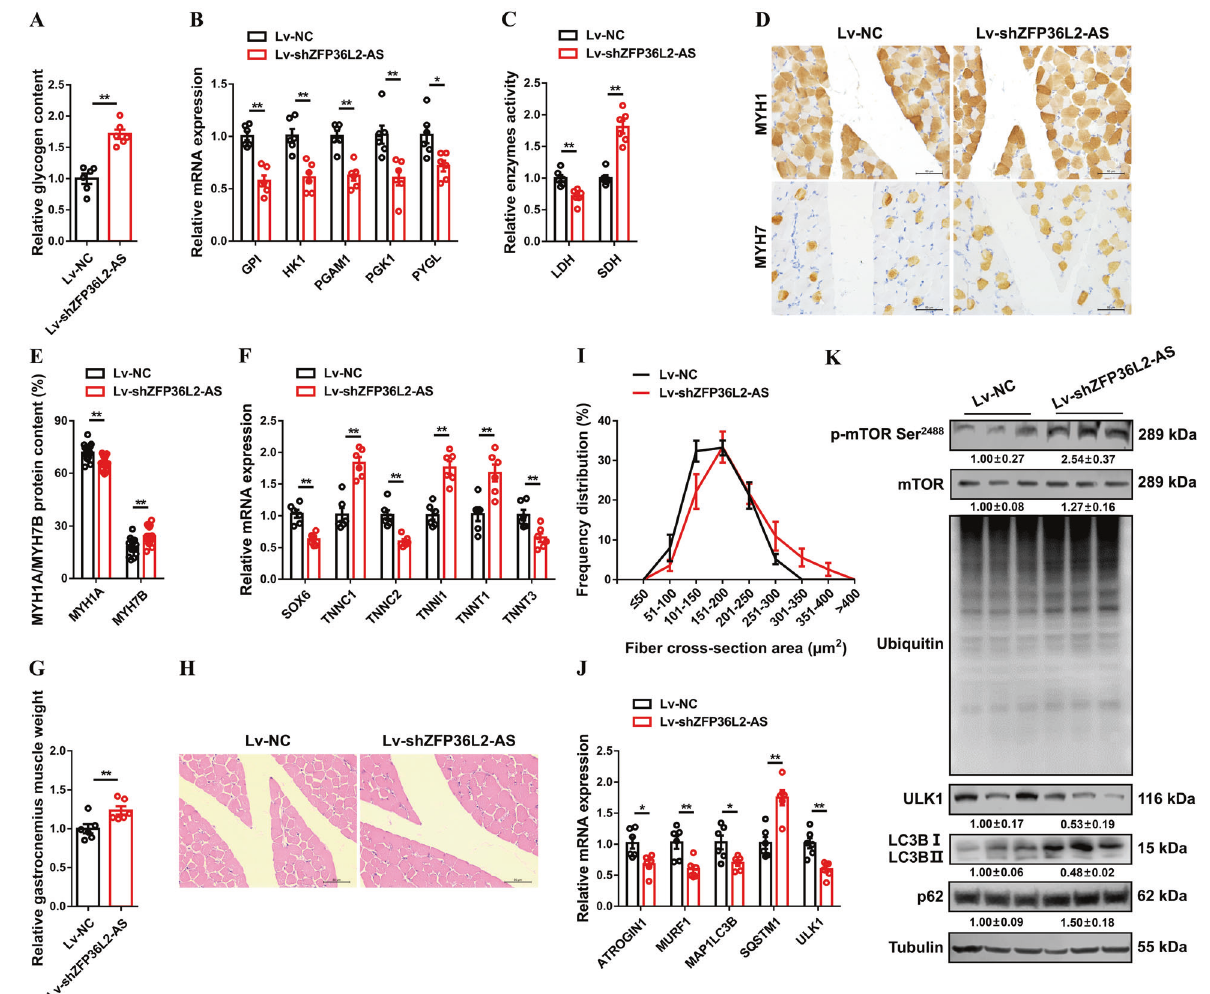
Fig. 5 lncRNA ZFP36L2-AS activates a fast-twitch gene expression pro fi le concurrent with muscle atrophy. A Relative glycogen content in gastrocnemius with ZFP36L2-AS knockdown. B Relative mRNA expression levels of glycogenolytic and glycolytic genes in gastrocnemius after infected with the indicated lentivirus. ( C ) Relative enzymes activity of lactic dehydrogenase (LDH) and succinate dehydrogenase (SDH) in gastrocnemius infected with ZFP36L2-AS knockdown. D , E Immunohistochemistry analysis of MYH1/MYH7 ( D ) and MYH1/MYH7 protein content ( E ) of gastrocnemius after ZFP36L2-AS knockdown. ( F ) Relative mRNA expression levels of several fast-/slow-twitch myo fi ber genes with ZFP36L2-AS knockdown. G Relative gastrocnemius muscle weight after infected with the indicated lentivirus. H , I H&E staining ( H ) and frequency distribution of fi ber cross-section area (CSA) ( I ) of transverse sections of gastrocnemius with ZFP36L2-AS knockdown. J Relative mRNA expression of the atrophy and autophagy-related genes in gastrocnemius after infected with the indicated lentivirus. K The protein expression levels of mTOR signaling after ZFP36L2-AS knockdown. The numbers shown below the bands were folds of band intensities relative to control. Band intensities were quanti fi ed by ImageJ and normalized to β -Tubulin. Data are expressed as a fold-change relative to the control. Results are presented as mean ± SEM. In panels ( A – C , E – G , and J ), statistical signi fi cance of differences between means was assessed using independent sample t -test. (* P < 0.05; ** P <